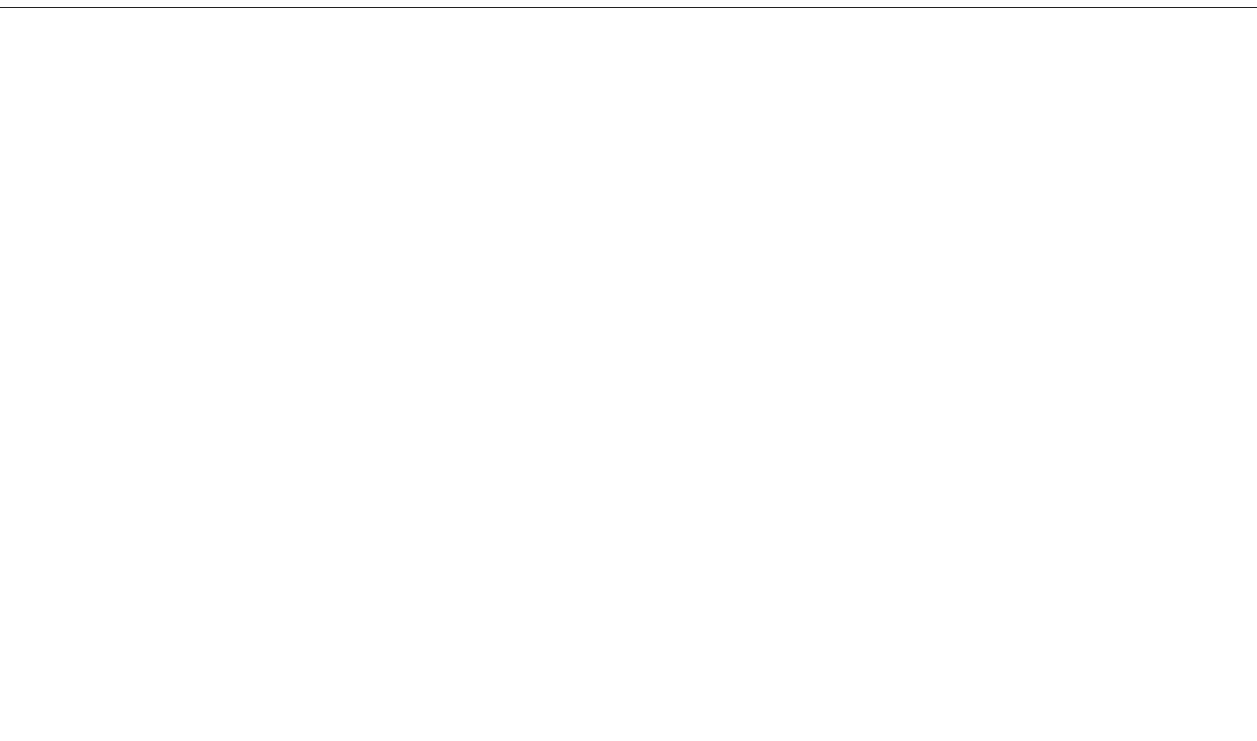
FIGURE 1 | Molecular framework for the Echinoid-based polarity reconstitution system. (A) Top: Domain architecture of the full-length Ed protein depicts an extracellular region containing several Immunoglobulin (Ig; yellow) and Fibronectin (FN; orange) cell adhesion domains that participate in formation of cell clusters. The transmembrane (TM; blue) region allows for insertion as an integral plasma membrane protein. The C-terminal tail (sequence following vertical dash line) resides intracellularly and is responsible for protein-protein interactions that participate in maintenance of adherens junction function and signaling. Bottom: Cloning of Ed for use in the induced polarity assay omits most of the intracellular tail to avoid interactions with known binding partners. This sequence is replaced with an in-frame green fluorescence protein (GFP; green) coding sequence. (B) The modified Ed:GFP sequence (with GFP replacing native C-terminal sequence) is cloned into the pMT/V5-His plasmid followed by 5 ′ - Bgl II and 3 ′ - Sal I cloning sites. Standard molecular cloning can easily generate Ed:GFP fusions to ostensibly any gene or sequence fragment the user wishes to examine. Cells are then transiently transfected with the cloned plasmid, and Ed:GFP fusion proteins are expressed using copper sulfate activation of the pMT promotor (see “Stepwise